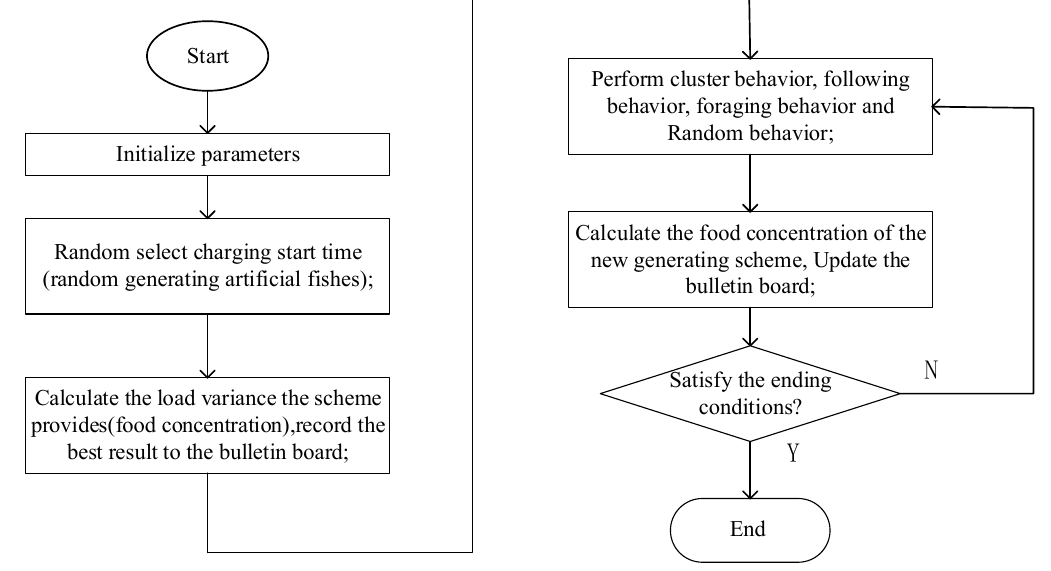
Figure 4. Flowchart of the artificial fish swarm algorithm.